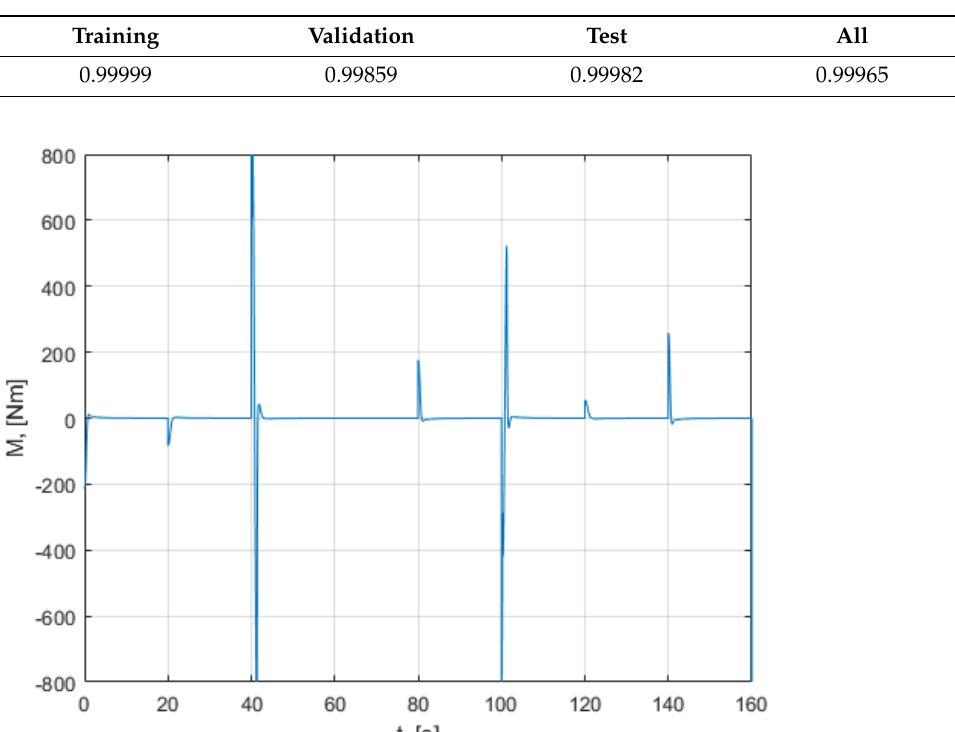
Figure 29. Command torque characteristic.